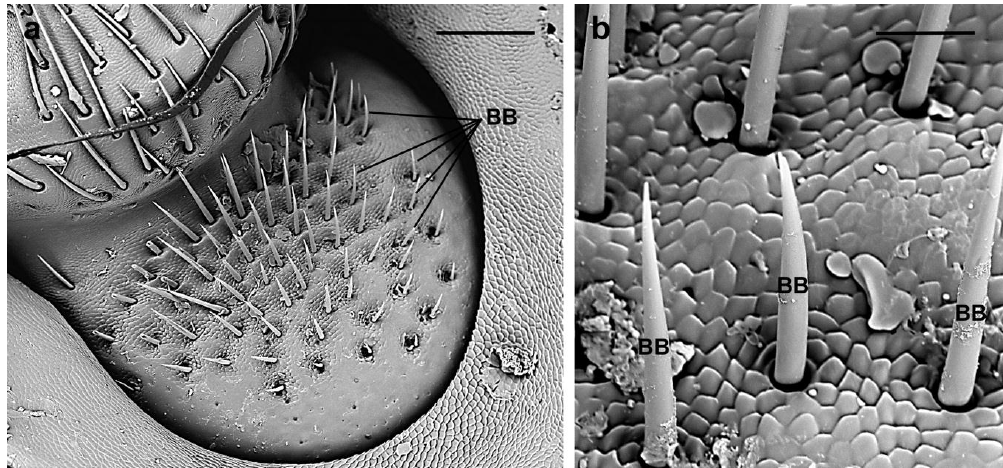
Figure 8. A. bungii female antenna at the level between head and scape, SEM. ( a ) Böhm bristles: Spine-shaped sensilla inserted into well-developed cuticular sockets. ( b ) Detail of the sharp tips and smooth cuticle. Abbreviations: BB, Böhm bristle. Scale bars: 150 µm ( a ); and 25 µm ( b ).